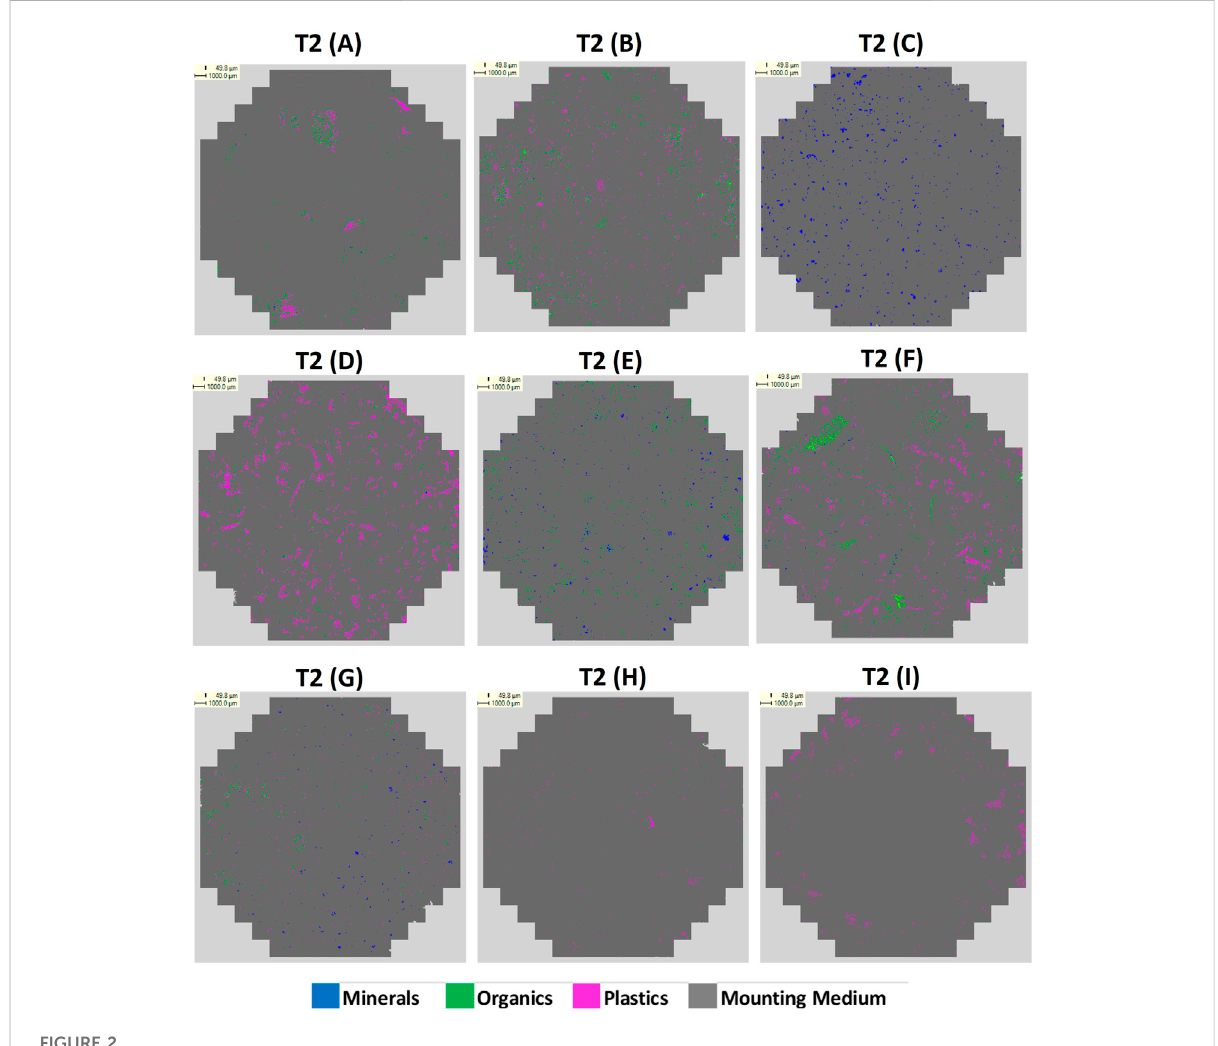
FIGURE 2 Particle map images for T2, samples A –